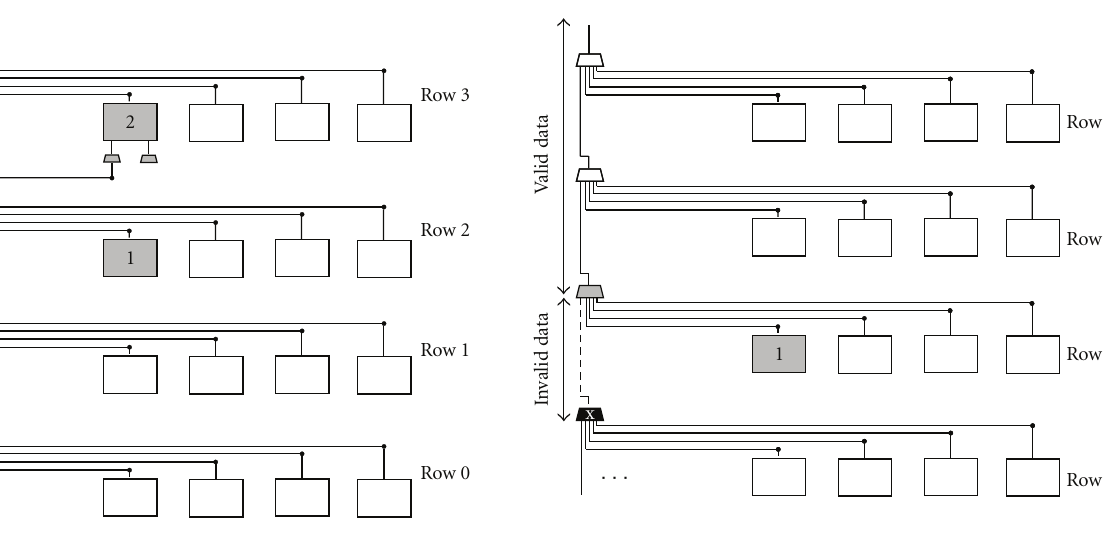
Figure 11: Defective output multiplexer/writing case solution— instruction 1 is placed in the next available row with nondefective output multiplexer (row